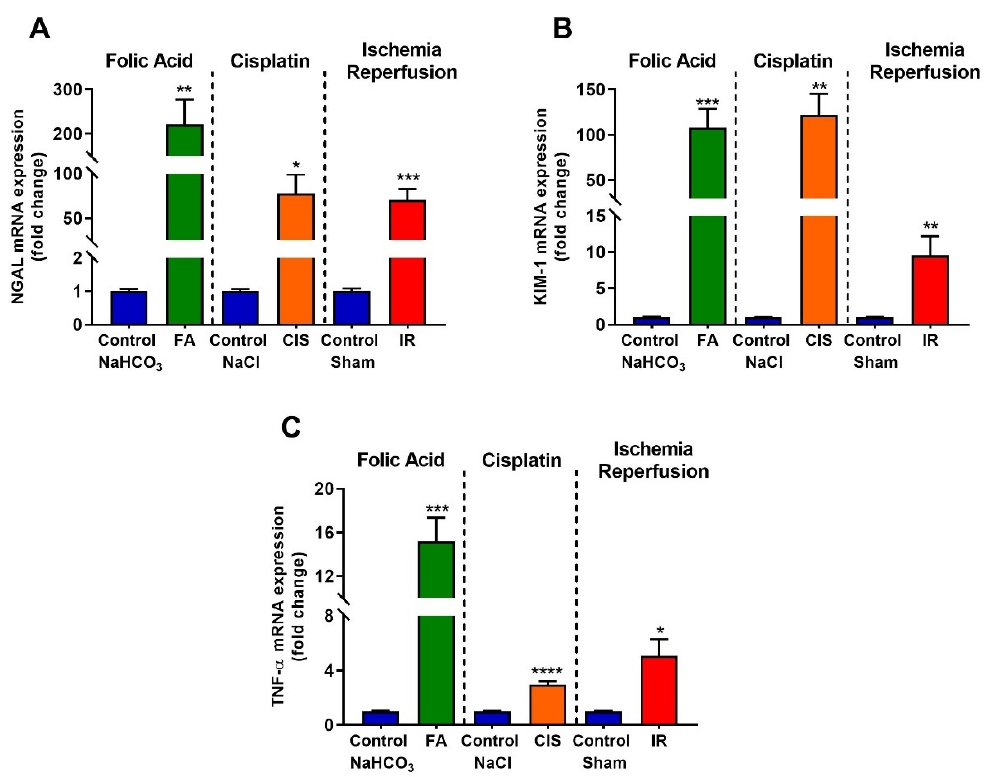
Figure 2. Chronic kidney disease increases mRNA levels of kidney injury markers. Renal injury was confirmed by increased mRNA levels of NGAL ( A ), KIM-1 ( B ), and TNF- α ( C ) after folic acid (FA) treatment, cisplatin (CIS) treatment, and ischemia reperfusion (IR) surgery. Data presented as mean ± SEM; n = 6. Two-tailed Student’s t-test. * p < 0.05; ** p < 0.01; *** p < 0.001; **** p < 0.0001.